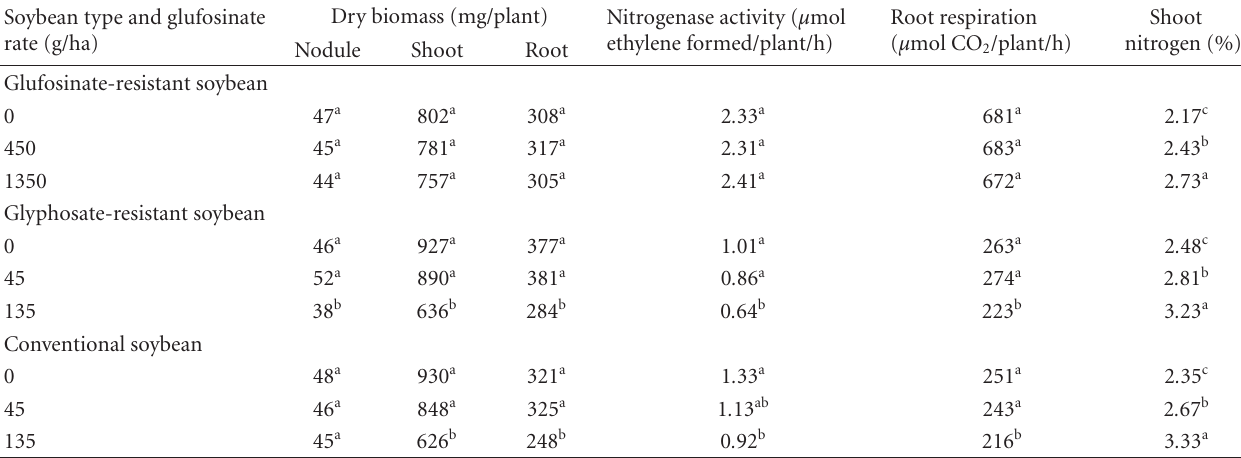
Table 7: E ff ect of glufosinate on soybean biomass, nodule biomass, nitrogenase activity, root respiration, and shoot nitrogen content, 12 d after application under greenhouse conditions ab